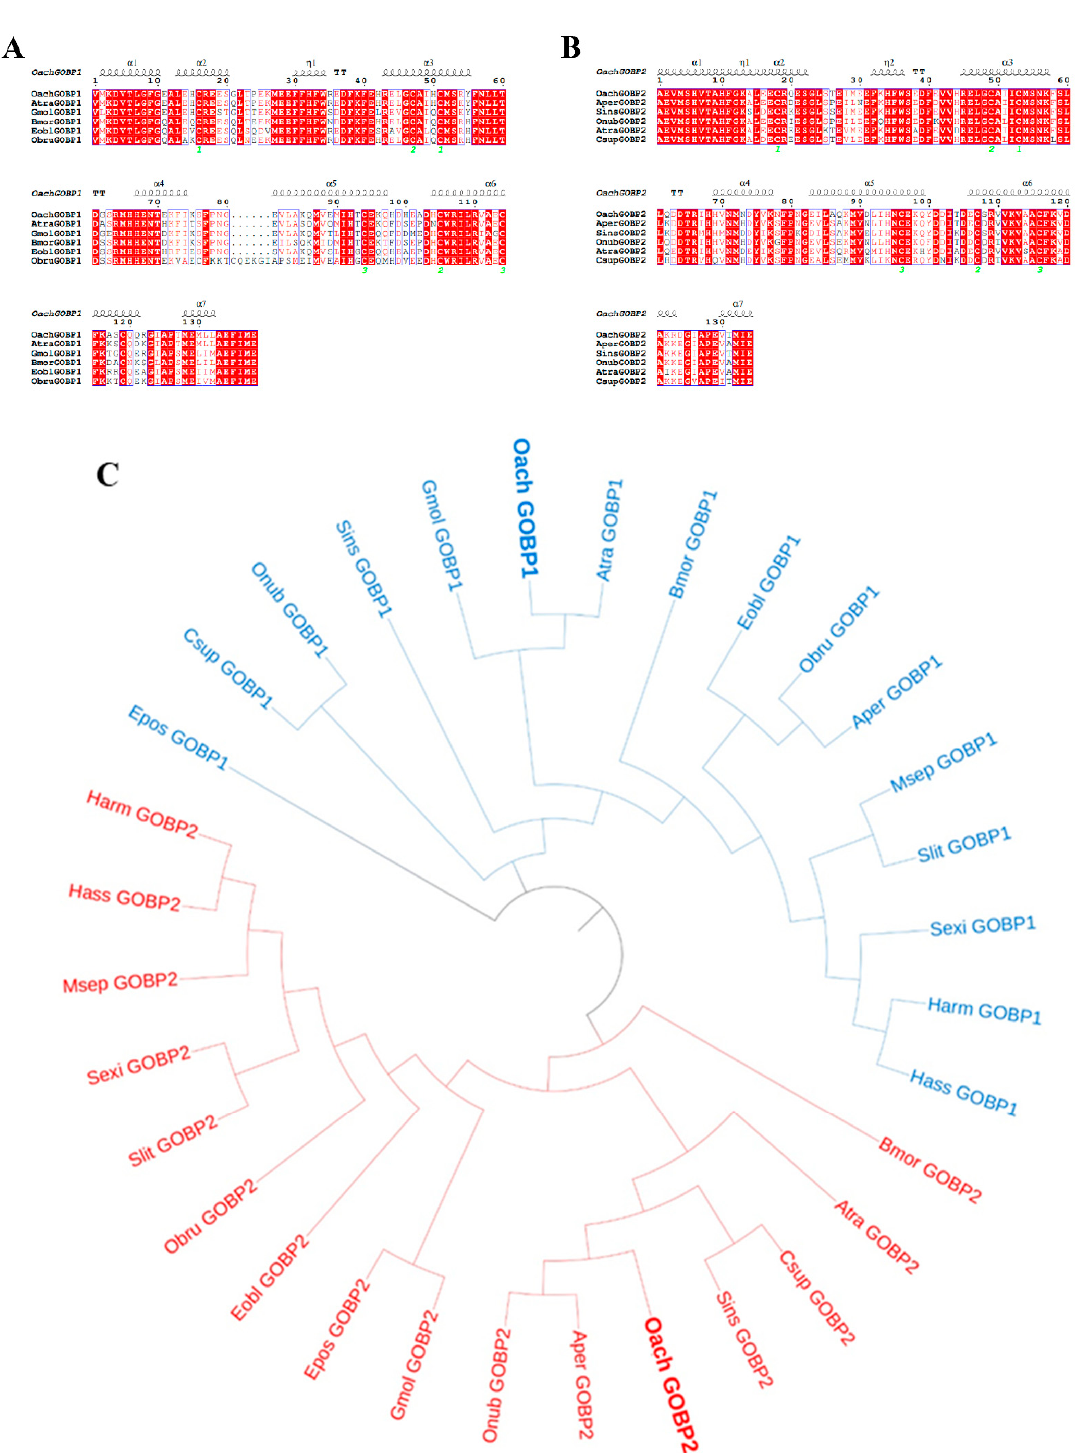
Figure 1. Sequence alignment and phylogenetic analysis of OachGOBPs. A and B : amino acid sequence alignment of OachGOBP1 and OachGOBP2 with their orthologs of lepidopteran insects. The disulfide bridges are numbered 1 to 3. The top line mark the position of alpha-helix ( α 1-7). Values at the nodes are the mean amino acid sequence length. The predicted conservative domain is represented in the blue box and 100% conserved residue is represented in the red shadow. C : phylogenetic analysis of OachGOBPs.